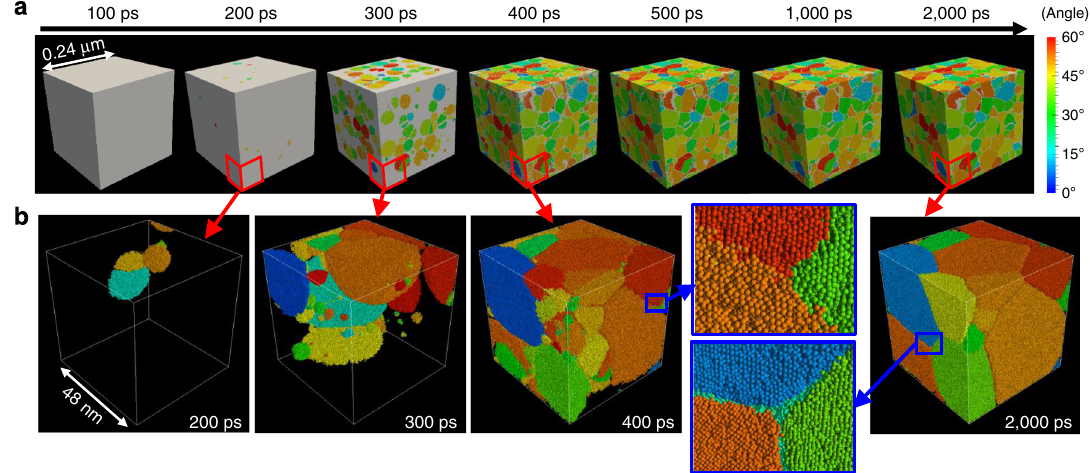
Fig. 2 Snapshots of the simulation cell during a 2,000 ps calculation for a temperature of 0.67 T m . a Whole simulation cell and b part of the simulation cell indicated by red lines in a . All grains are coloured in accordance with the disorientation angle relative to the coordination axis. Areas of liquid and grain boundaries are coloured in white in a and are not shown in b . Inset fi gures represent enlarged views of the atomic con fi guration in the areas indicated by blue